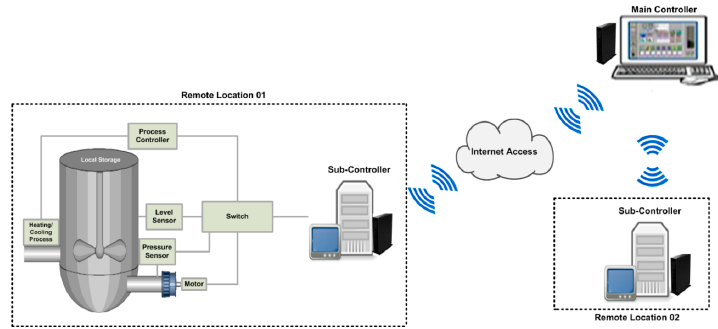
Figure 3. Simulation design and environment.